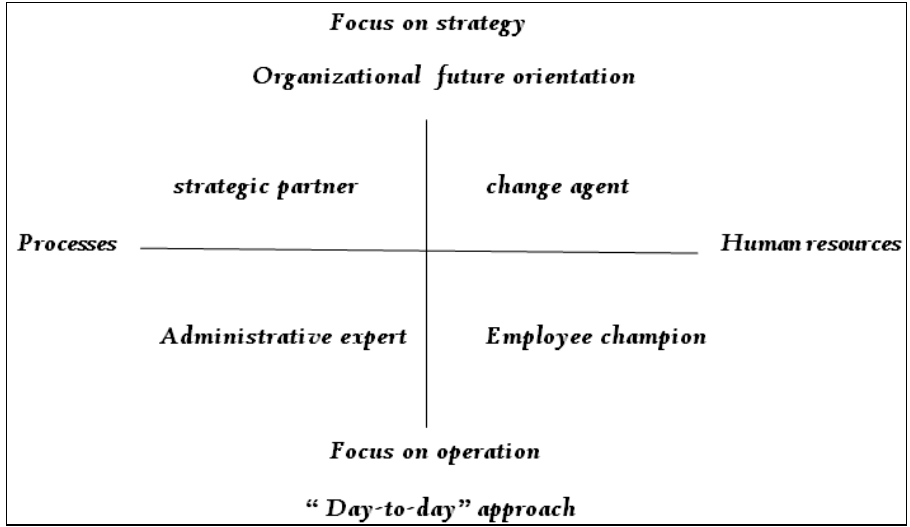
Figure 4: The HR Management Functions